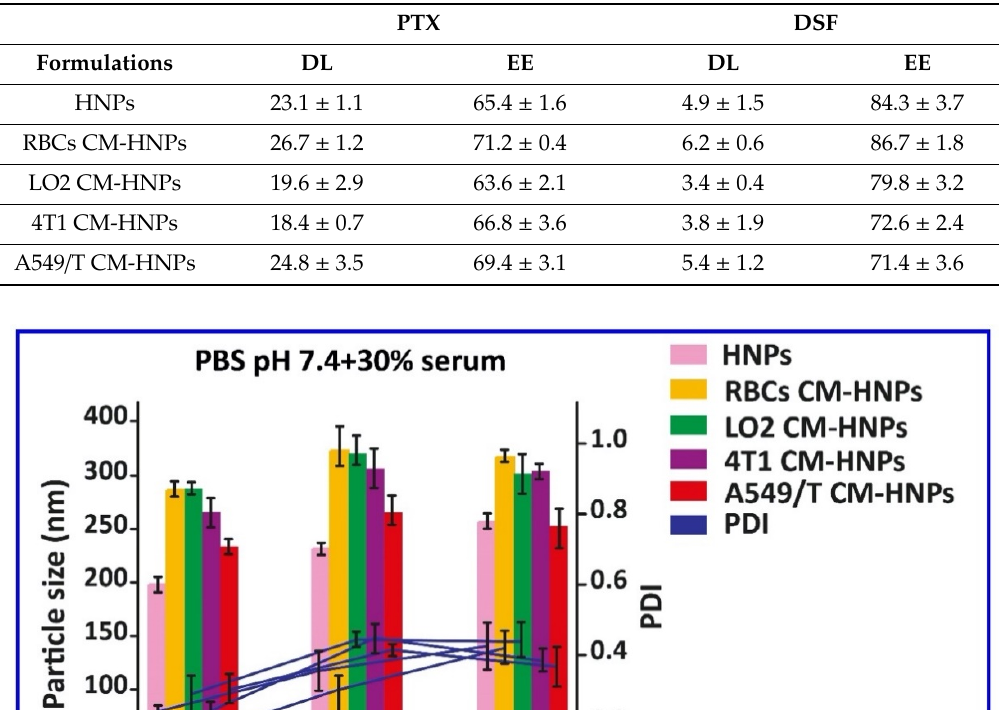
Table 1. Drug loading (DL) and encapsulation e ffi ciency (EE) of various formulations.